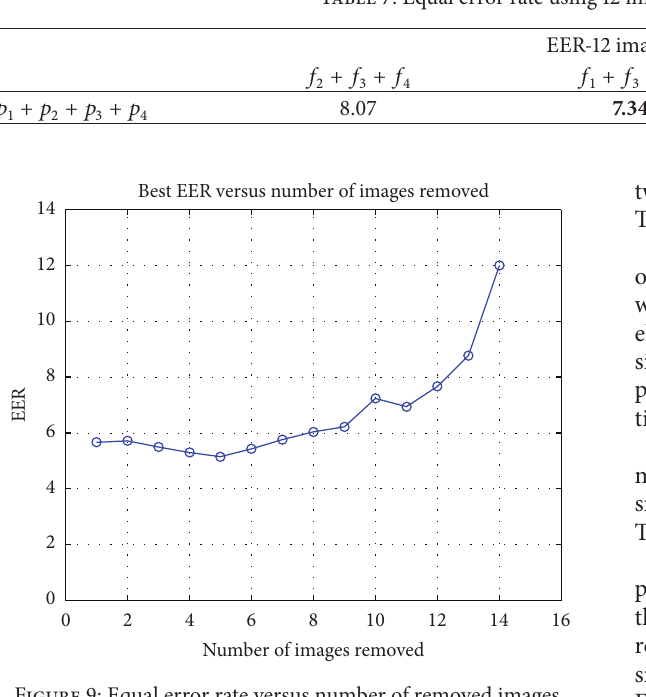
Figure 9: Equal error rate versus number of removed images.